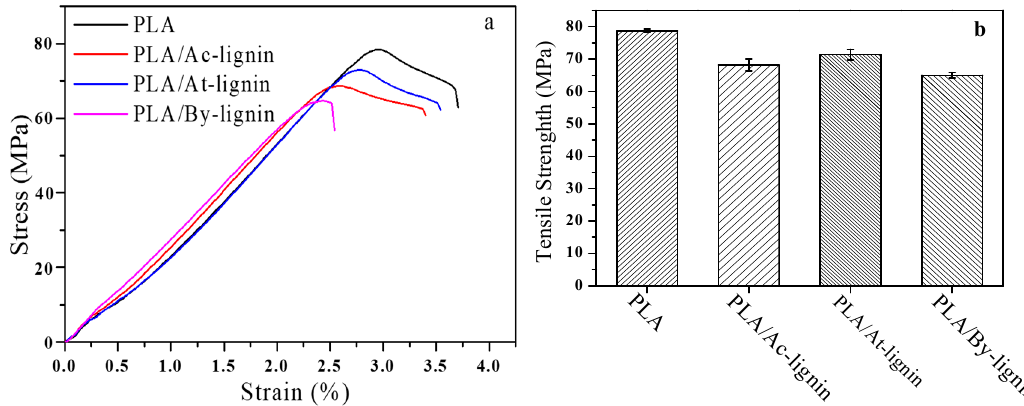
Figure 18. Tensile stress–strain curves ( a ) and tensile strength statistical histogram ( b ) of pure PLA and PLA/lignin biocomposites.